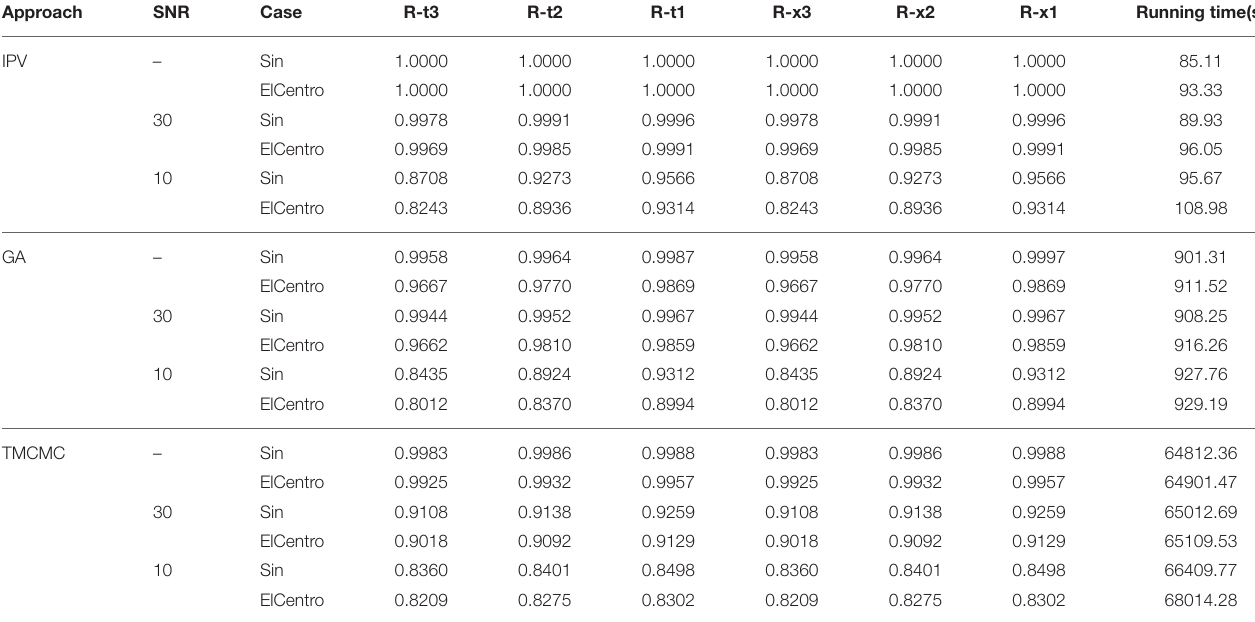
TABLE 3 | Correlation coefficient analysis for different cases.